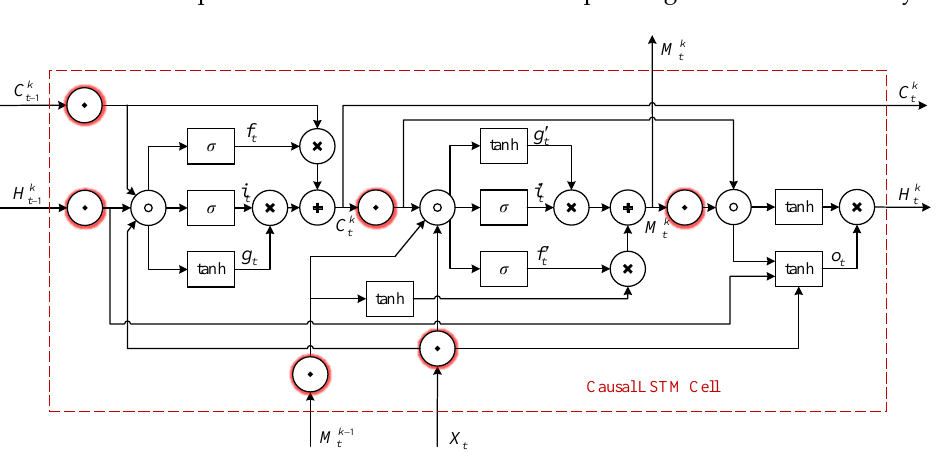
Figure 3. Causal LSTM cell.